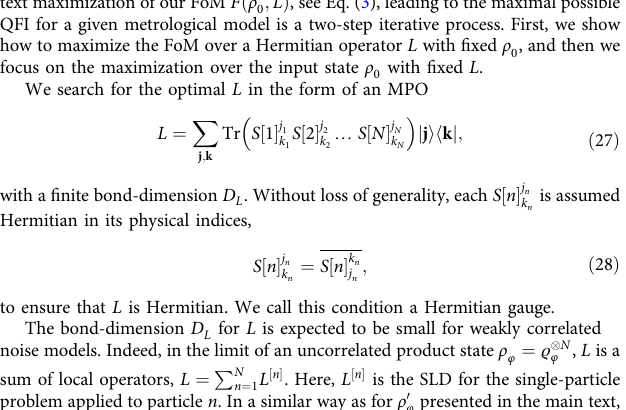
F ¼ 4 χ φ . This exact susceptibility for the chain with 64 spins is shown in Fig. 4, together with the upper and lower bounds (Eq. 25). The accuracy of the fi delity susceptibility is limited by the fi nite bond-dimension D as well the fi nite parameter difference ε . L